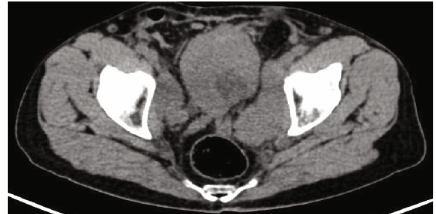
Figure 6: Pelvic scan showing a 6 × 3 : 5 cm mass of the anterior and right lateral wall of the bladder with di ff use in fi ltration of the bladder fat.